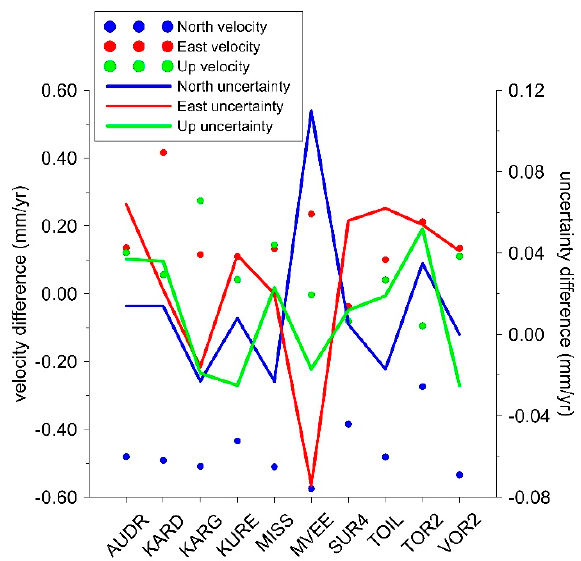
Figure 11. Differences between velocities and their uncertainties of GOA_2 and BERN_2 solutions (GOA_2 minus BERN_2, using FN + WN model for N and E, and GGM model for U).